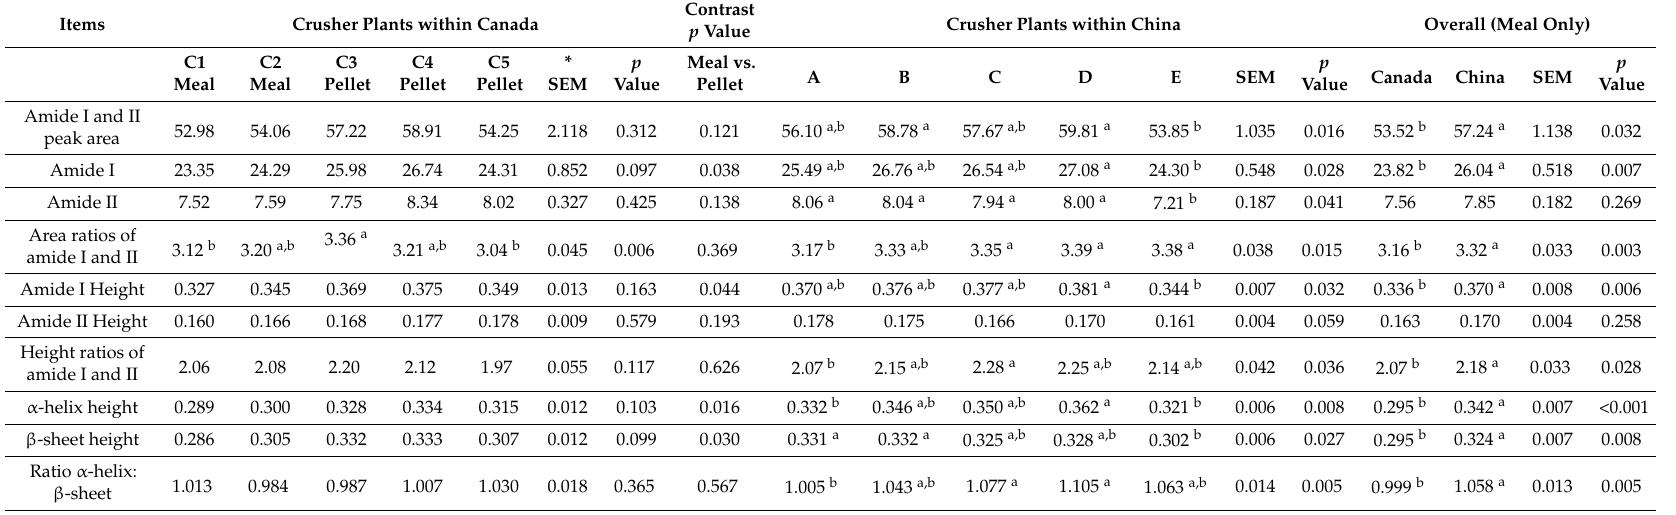
Table 6. Protein molecular structure characteristics of co-products from bio-oil processing (canola meal): Comparison of crusher plants within Canada and within China as well as between Canada and